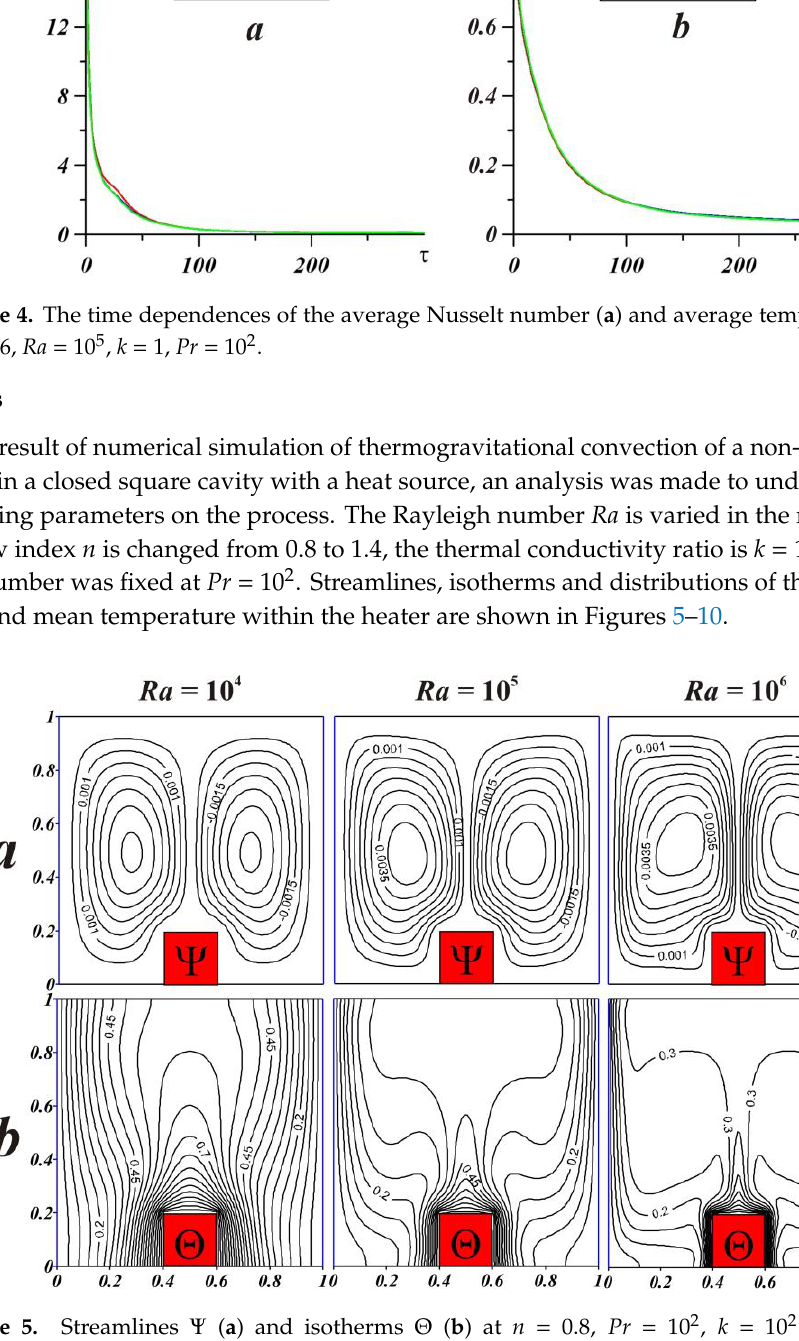
Figure 5. Streamlines Ψ ( a ) and isotherms Θ ( b ) at n = 0.8, Pr = 10 2 , k = 10 2 and different Rayleigh numbers.